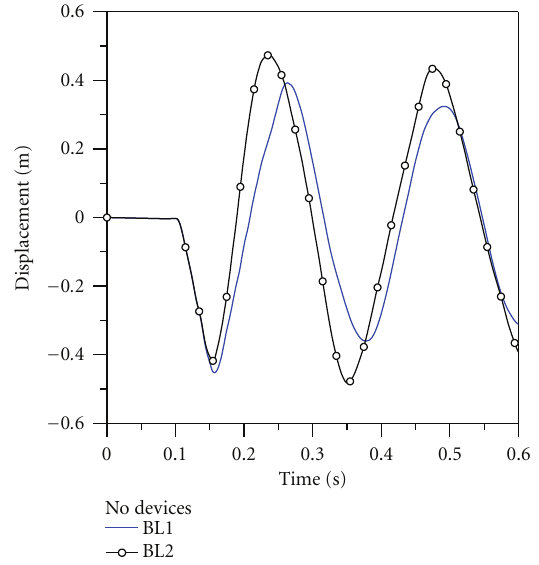
Figure 9: Comparison of mid-span cable deflection, as a function of time (ABAQUS). No devices. M01 FE-models, BL1 and BL2.